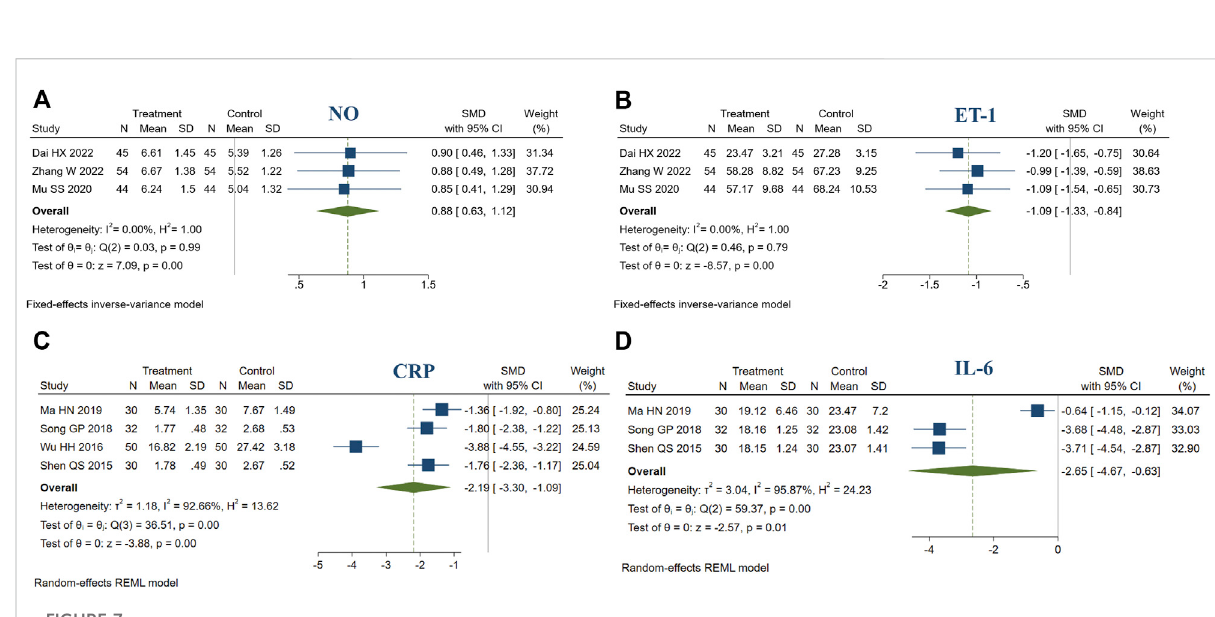
FIGURE 7 Forest plot of endothelial function and in fl ammatory biomarkers. (A) NO; (B) ET-1; (C) CRP; (D) IL-6.